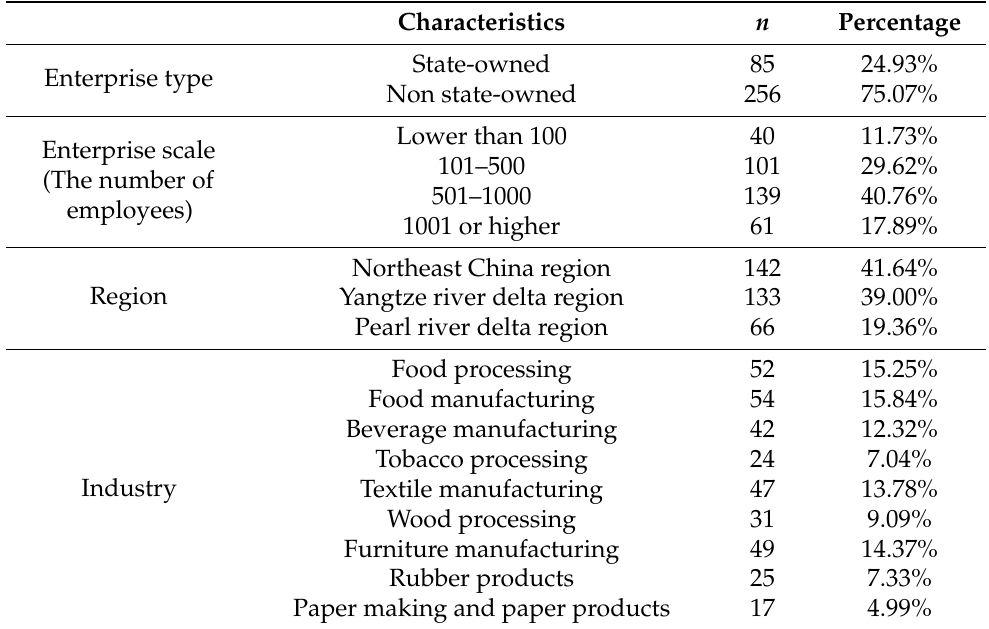
Table 1. Characteristics of agricultural enterprises ( n =